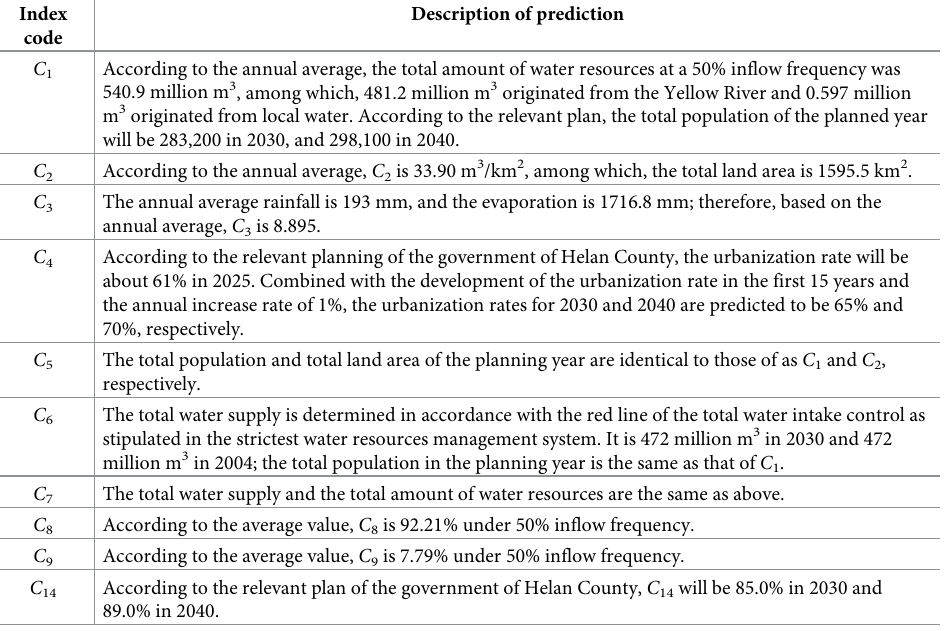
Table 3. Forecast description of Class A